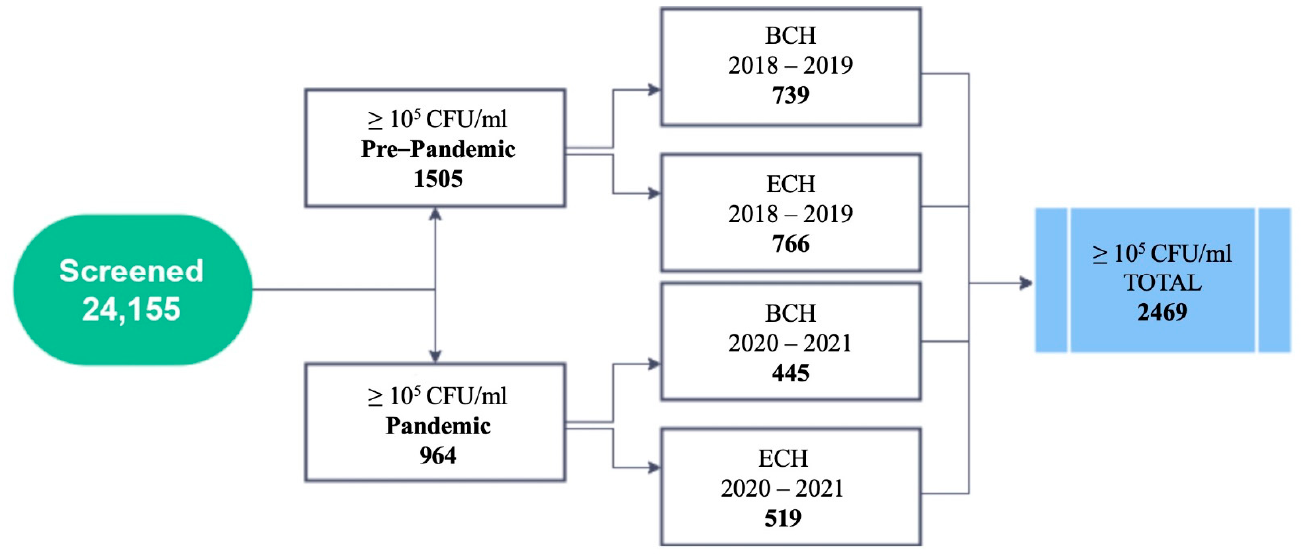
Figure 1. Diagram of the screened and enrolled patients in the study. Data included in the study considered information such as sex and age for both hospitalized and non-hospitalized patients; thus, it was not possible to record a more extensive history for the latter.